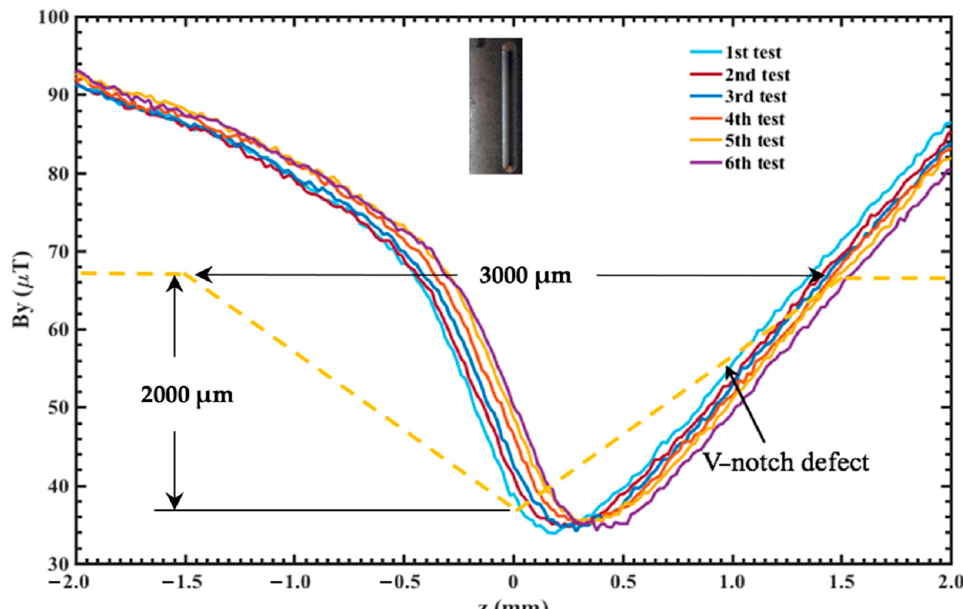
Figure 10. Variation of normal MMM signals measured around the fourth V-shaped notch (3000 µm width and 2000 µm depth) of the ASTM-A36 steel pipe, which were measured using six experimental tests.